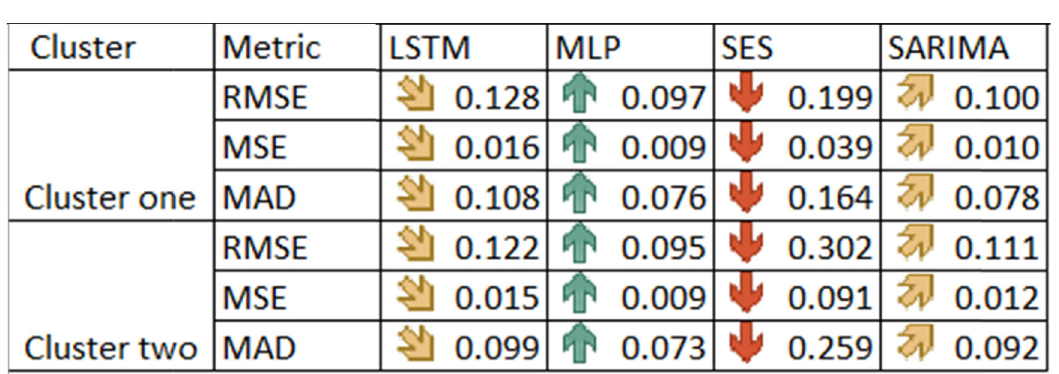
Table 6 Forecasting errors measures for the four compared methods.